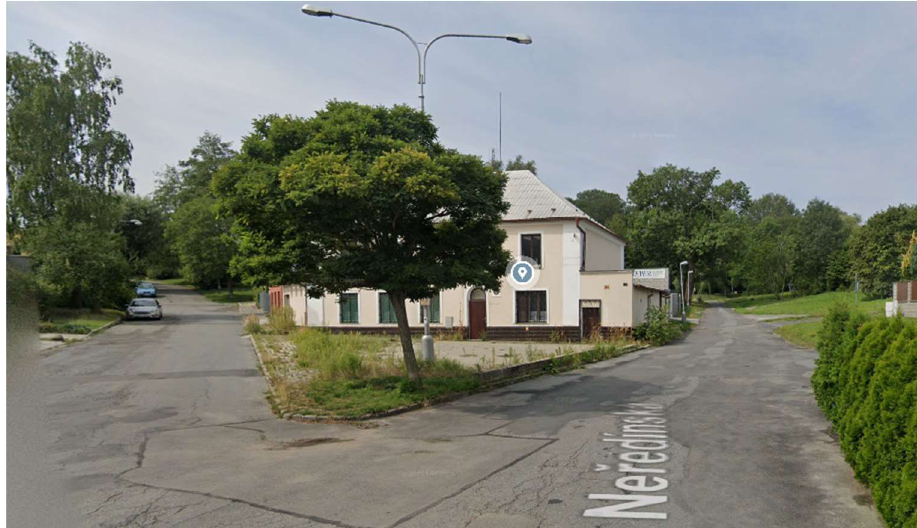
Figure 5. The residential (periphery) environment.